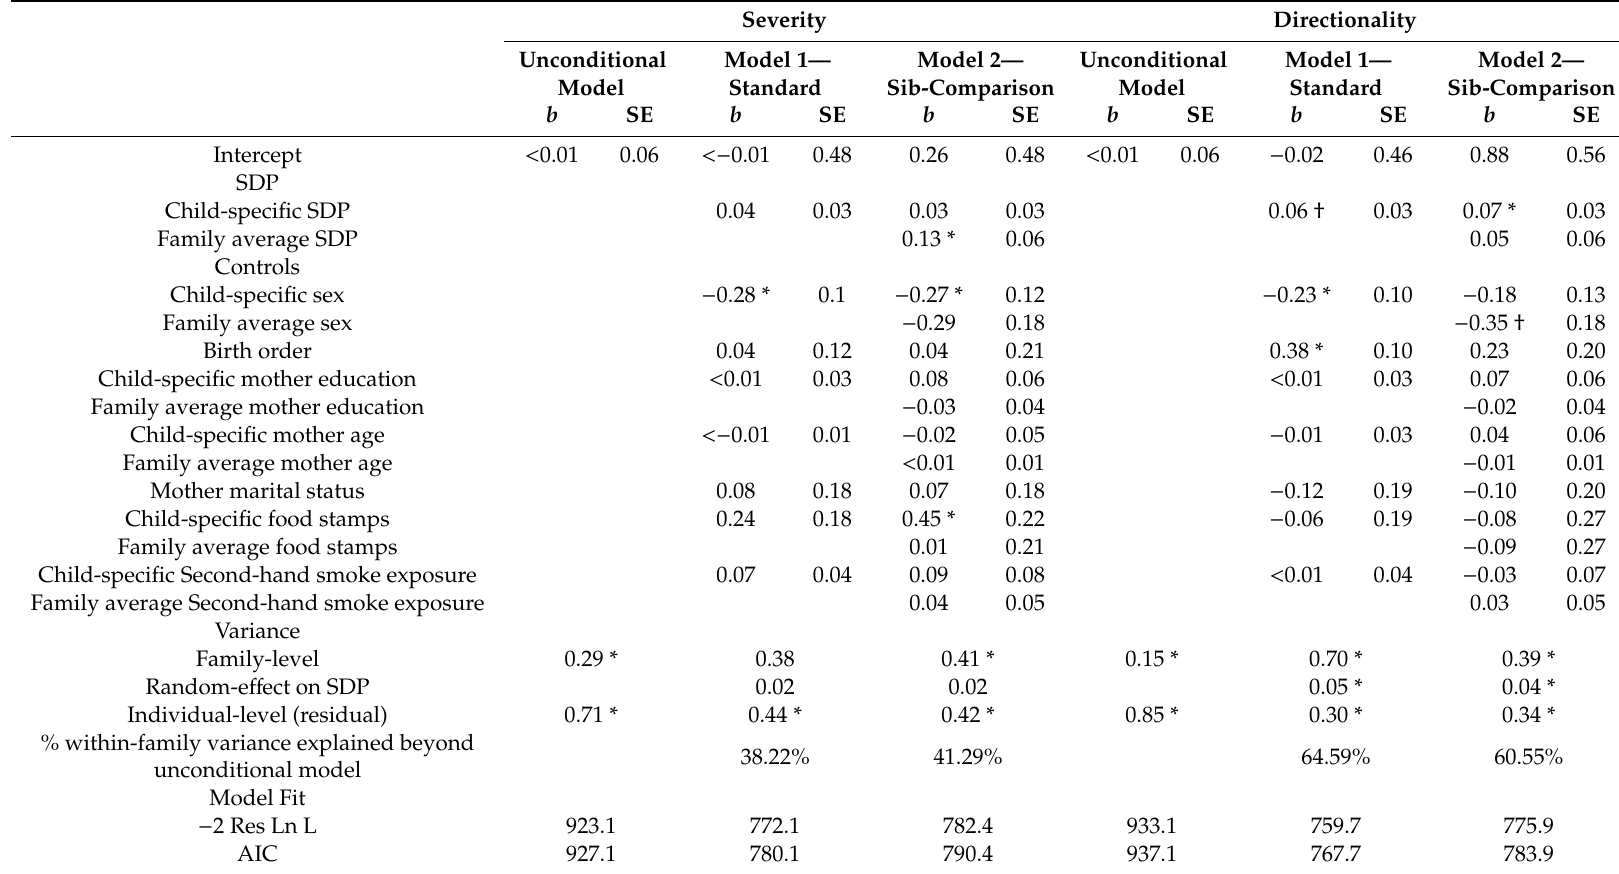
Table 2. Model Results of SDP Severity and Directionality